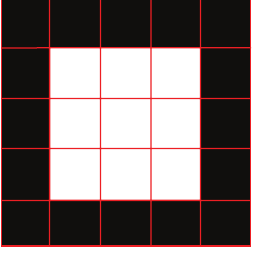
Figure 4: A simple example image with a square block of white pixels in the center. We assume that the white pixels are aggregated to a single, nonoverlapping block on level